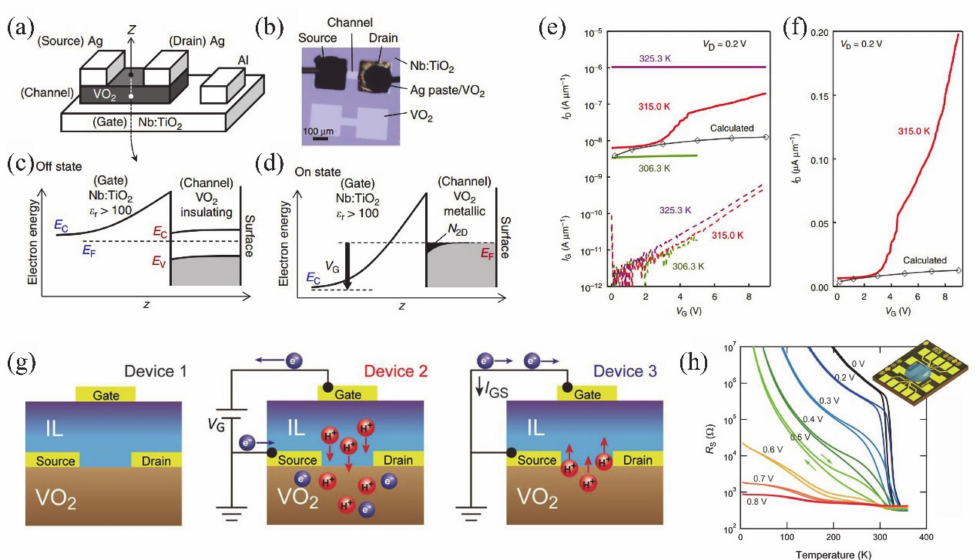
Figure 19. ( a – d ) Device structures and ( a ) a schematic illustration, ( b ) an optical micrograph and ( c , d ) the band diagrams of the fabricated transistor. ( e ) Transfer characteristics of the VO 2/ Nb:TiO 2 transistor with the drain voltage of 0.2 V. ( f ) Transfer characteristics at 315.0 K in the linear scale. Reproduced from [135], with permission from Springer Nature, 2015. ( g ) Schematics of VO 2 FET based on IL gate in the pristine state (Device 1), with gate-induced protonation (Device 2) and after returning to the pristine state (Device 3). ( h ) Temperature dependence of the channel resistance about the VO 2 FET based on ILs gate at various gate voltages. Reproduced from [138], with permission from John Wiley and Sons,